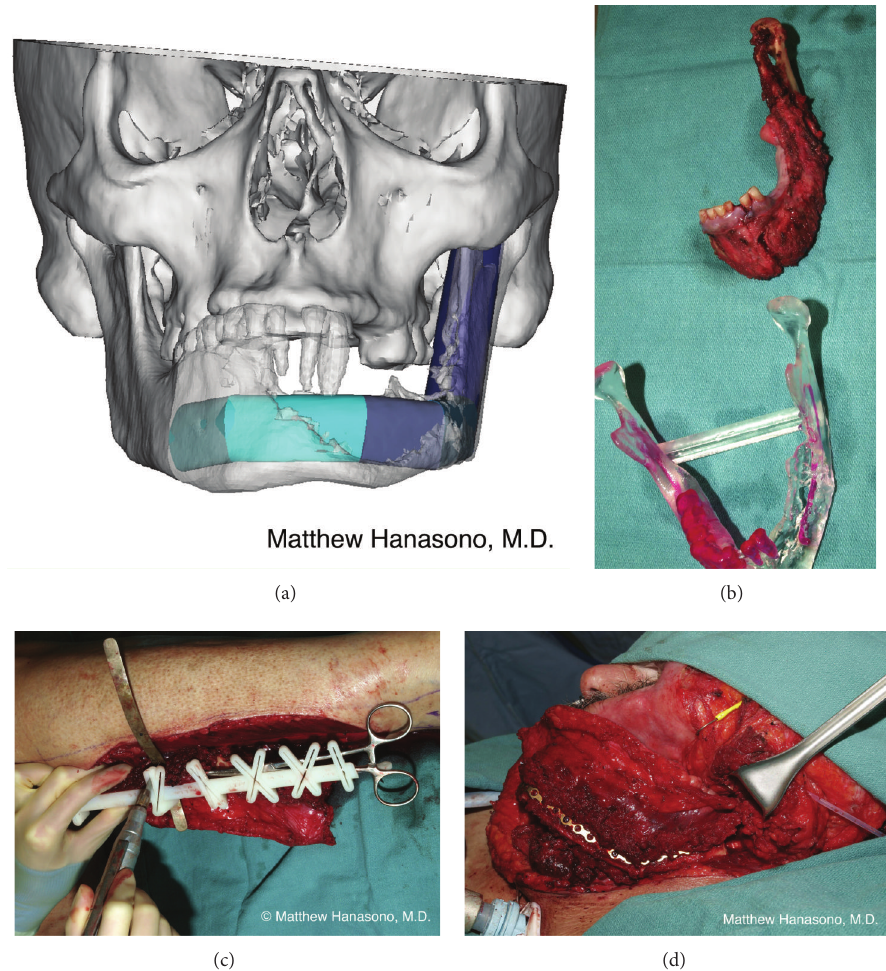
Figure 5: Virtual plan for mandibular reconstruction using computer-assisted design software (figure courtesy of Medical Modeling, Incorporated, Golden, CO) (a). Comparison of mandibular specimen to rapid prototype model (b). Computer-generated slotted cutting guide used to help make osteotomies in a fibula osteocutaneous free flap (c). Flap inset